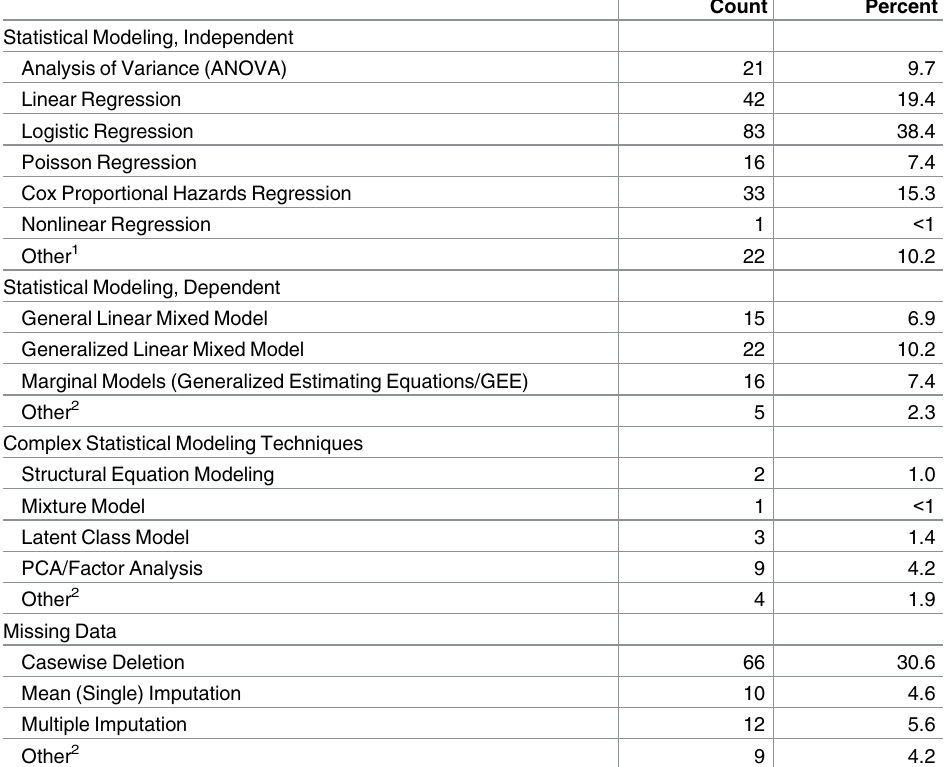
Table 3. Frequency of use reported for statistical modeling and related advanced statistical tech- niques (n =